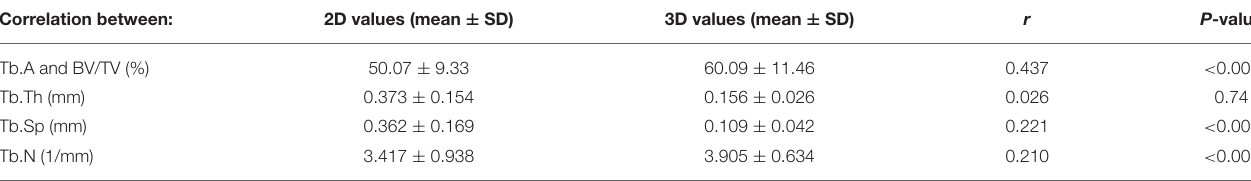
TABLE 5 | Mean values and correlation of Pearson coefficients between 2D histology and 3D micro-CT trabecular parameters. Correlation